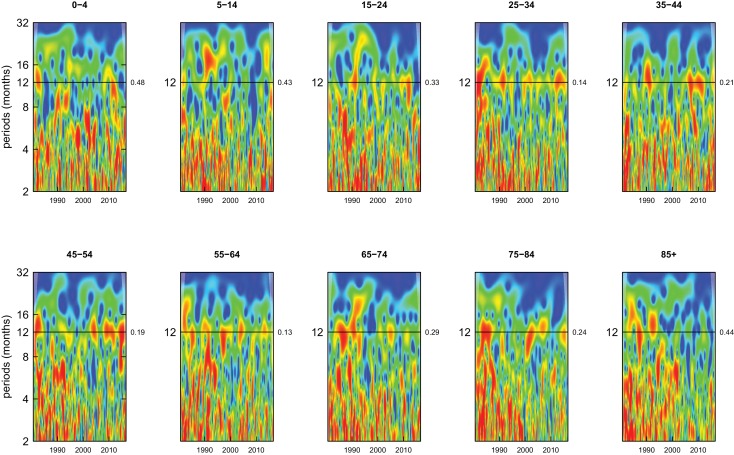
Wavelet power spectra for national time series of intentional injury death rates for 1980–2016, by age group for females.Wavelet power values increase from blue to red. The shaded regions at the left and right edge of each box indicate the cone of influence, where spectral analysis is less robust. P-values for the presence of 12 month seasonality are to the right of each figure at the 12 month line.